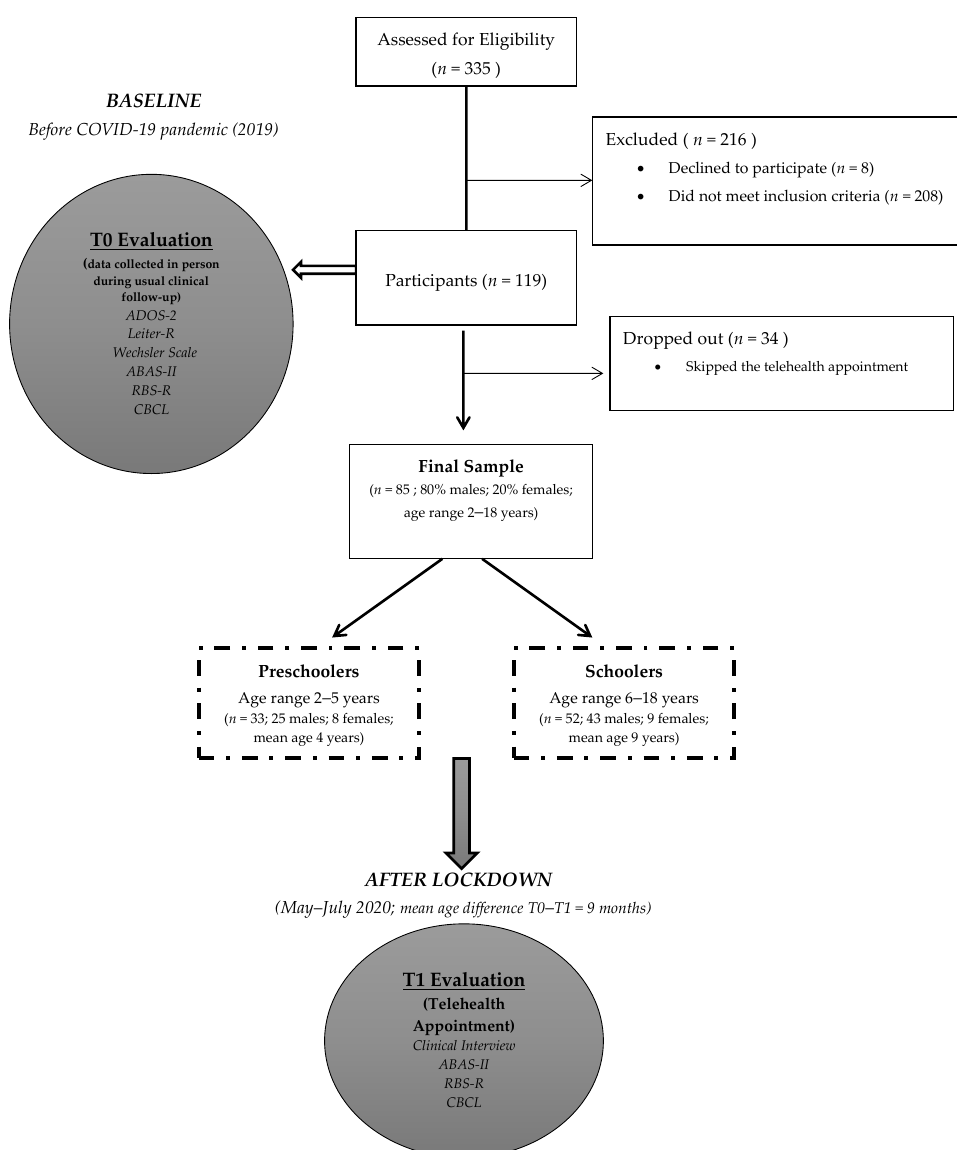
Figure 1. Flowchart of the study. Illustrated in the Figure are the main methods of the study (participants, procedure, and materi- als).